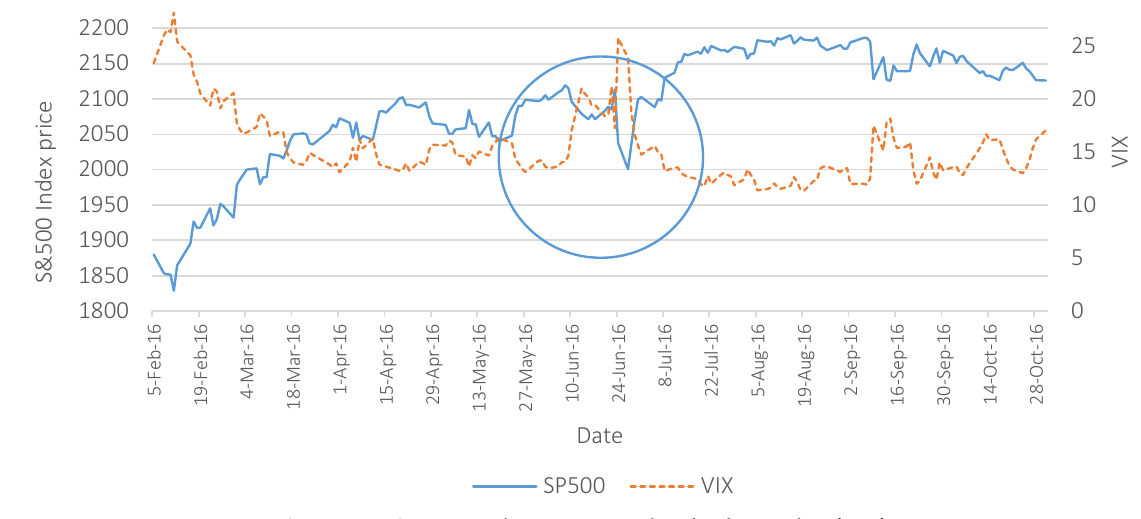
Figure 1. S&P500 Index prices and Volatility Index